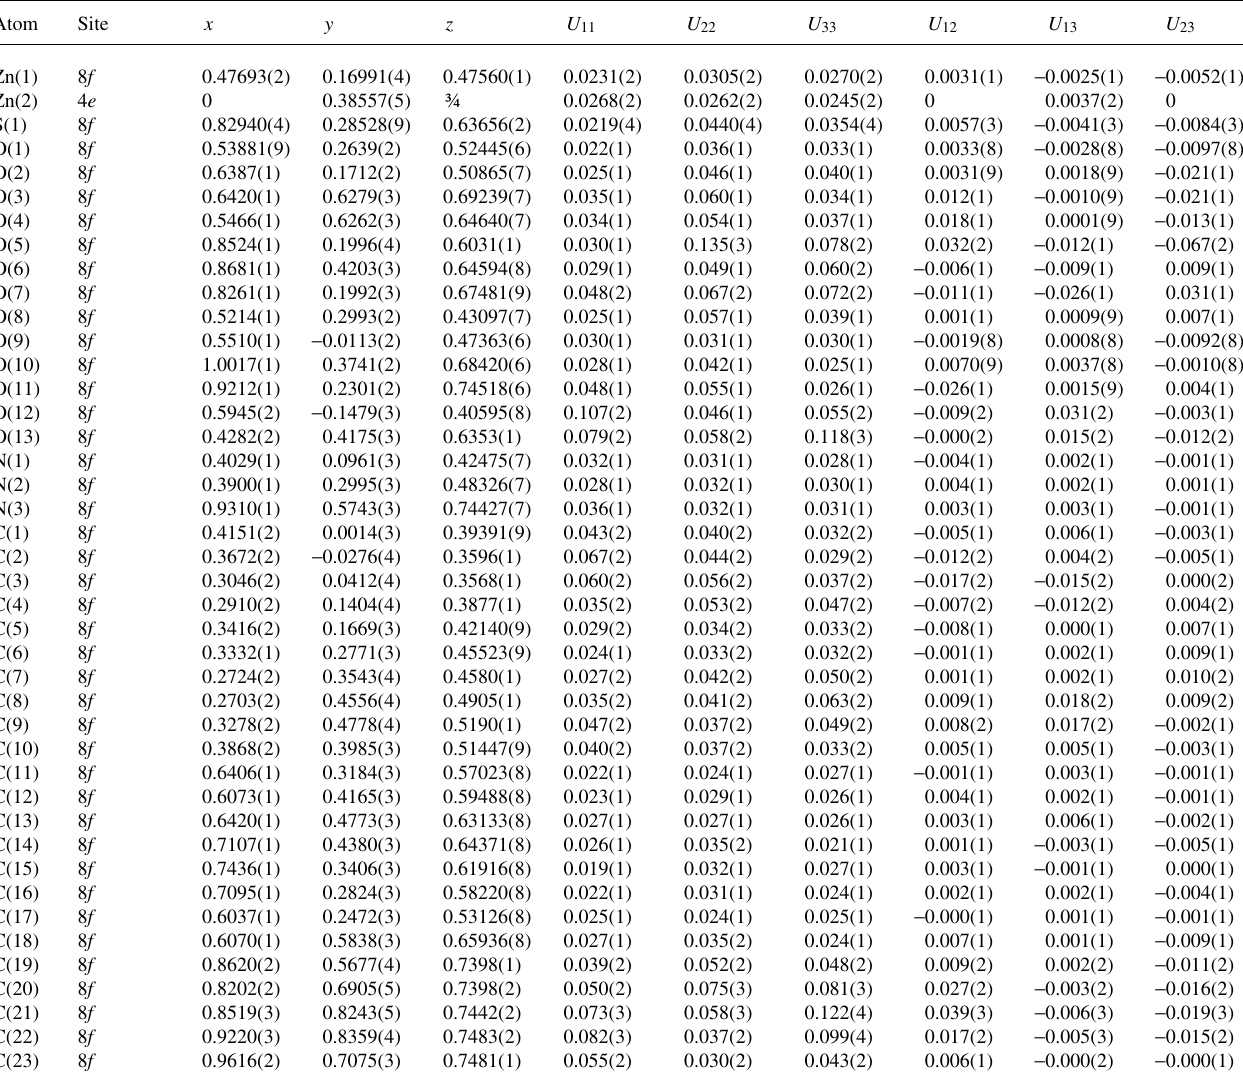
Table 3. Atomic coordinates and displacement parameters (in Å 2 ) .